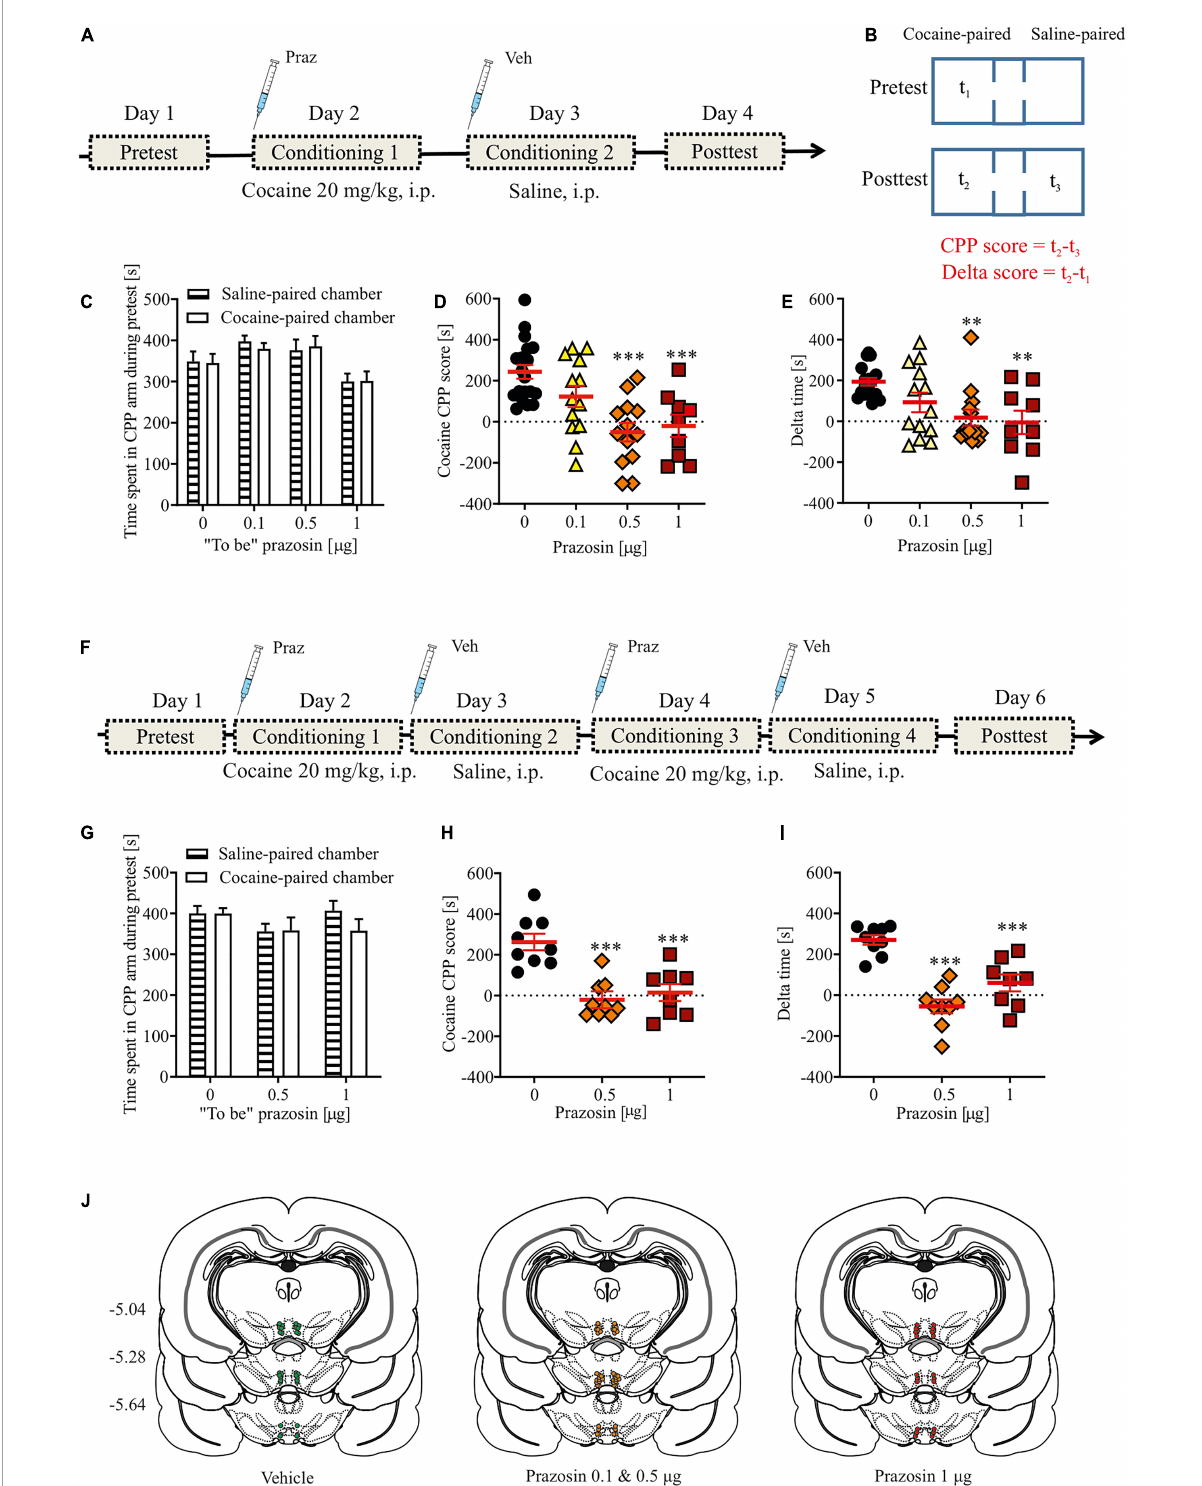
FIGURE1 Effects of α 1 -AR blockade in the VTA on the acquisition of cocaine-evoked CPP. (A,F) The experimental time-line and schedule of intra-VTA microinfusions during the acquisition of CPP induced by one (A) or two (F) cocaine (20 mg/kg, i.p.) conditionings. (B) Graphical representation of the two methods of calculating conditioned responses in the CPP paradigm. CPP score is defined as a difference between time spent (t 2 ) in the cocaine-paired chamber minus time spent in (t 3 ) control chamber (saline-paired) during post-conditioning (post-test). Delta score